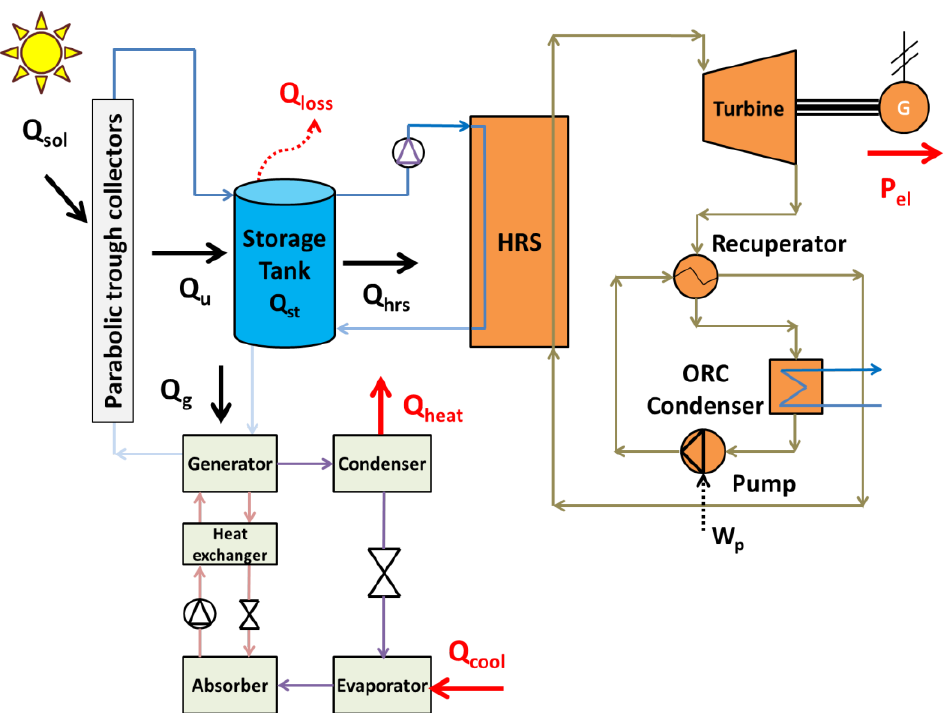
Figure 2. System 2 — The ORC and the ACH are fed separately by the solar field.